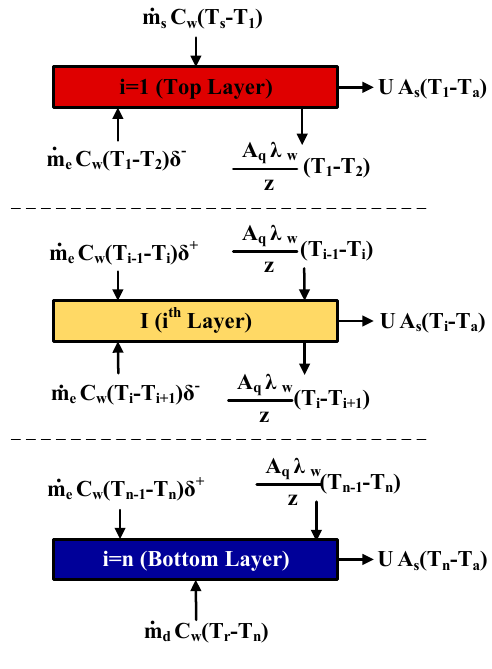
Figure 10. Energy flow in stratified